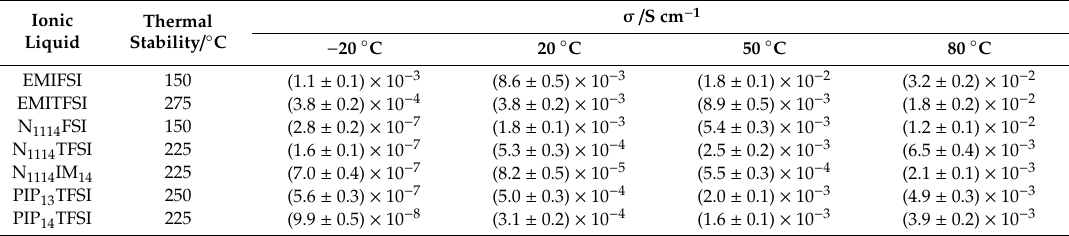
Table 1. Thermal stability and ionic conductivity ( σ ) values of 0.1NaTFSI-0.9IL sodium electrolytes.